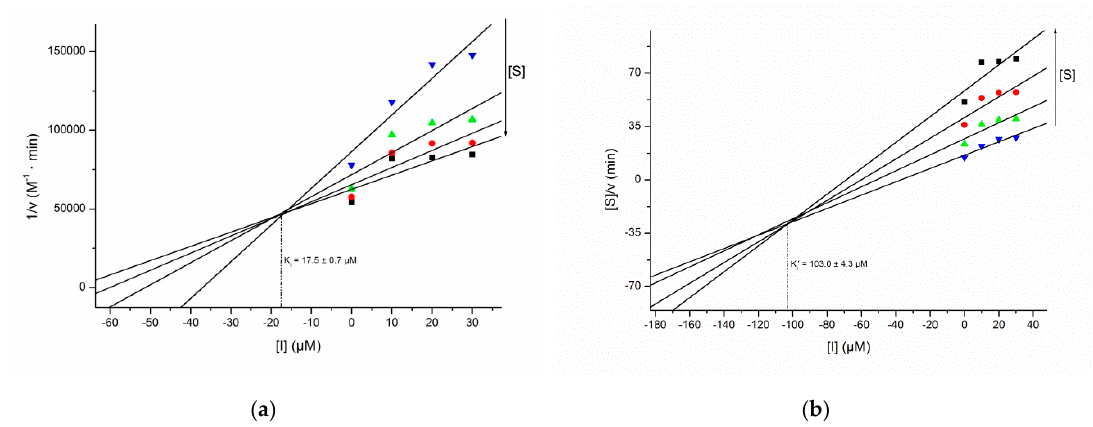
Figure 2. Dixon ( a ) and Cornish–Bowden ( b ) plots for the inhibition of AChE by compound 9 .